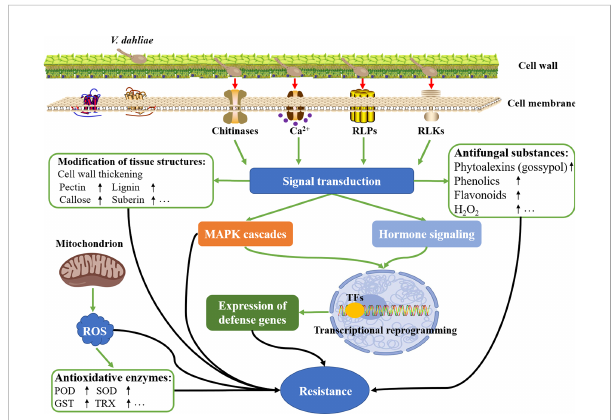
FIGURE 3 Molecular mechanisms of cotton resistance to V. dahliae